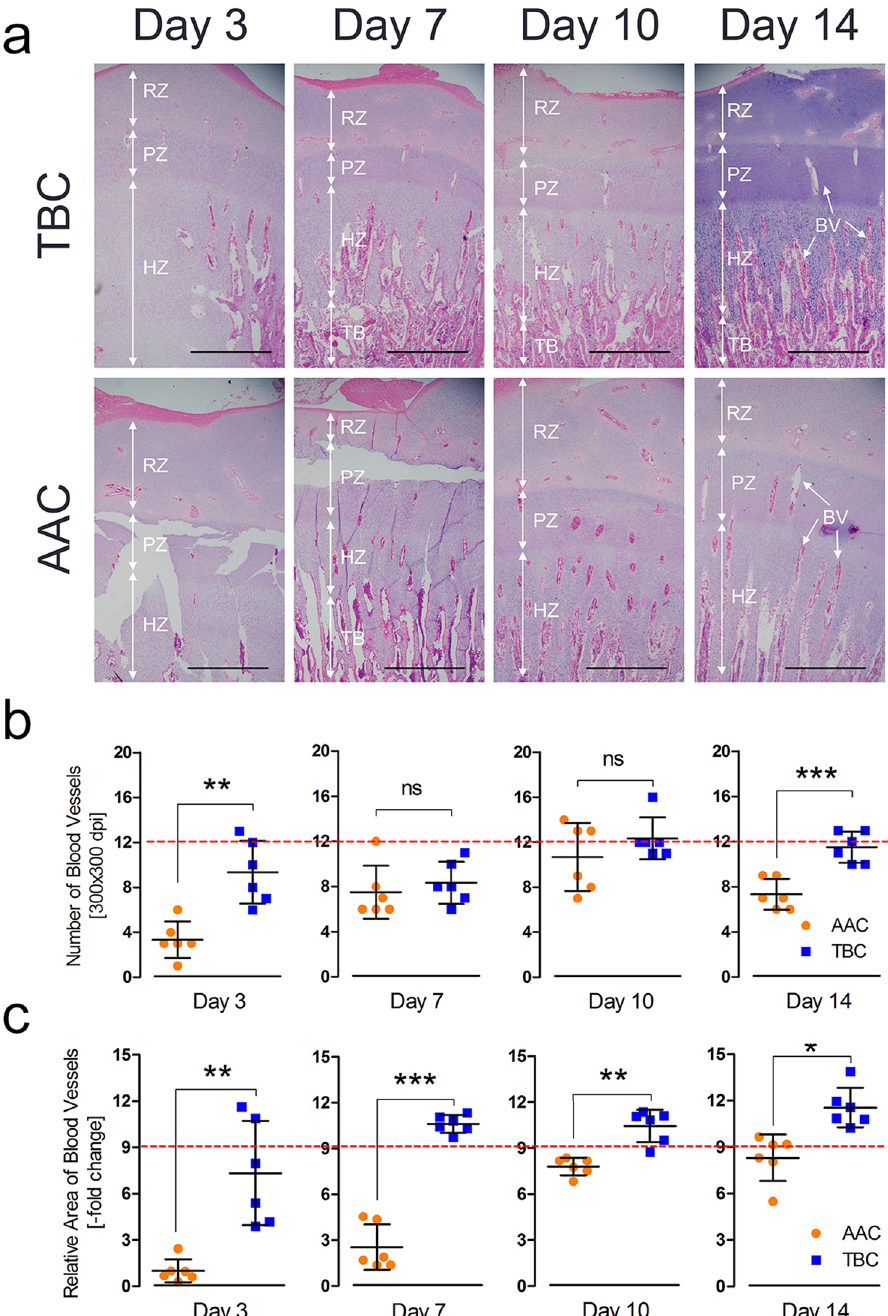
Figure 2. Higher tibial vascular distribution in the hypertrophic chondrocyte zones of TBCs. ( a ) Tibial vascular distribution was significantly increased in TBCs compared to AACs. The arrows indicate BVs (blood vessels); RZ, resting chondrocyte zone; PZ, proliferative chondrocyte zone; HZ, hypertrophic chondrocyte zone; and TB, trabecular bone. Scale bar = 500 µ m. ( b , c ) The relative BV area and BV number were determined from two isolated groups using Image-Pro ® Plus 6.0. Student’s t -test, * p < 0.05, ** p < 0.01, *** p < 0.001, n = 6; Error bars indicate SD. ns, not significant. AAC, Arbor Acres chicken; TBC, Tibetan